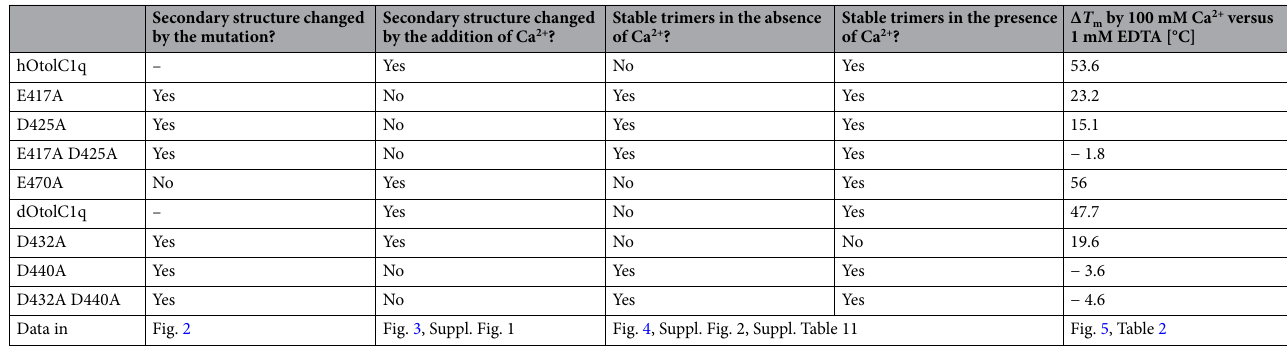
Secondary structure changed by the mutation?